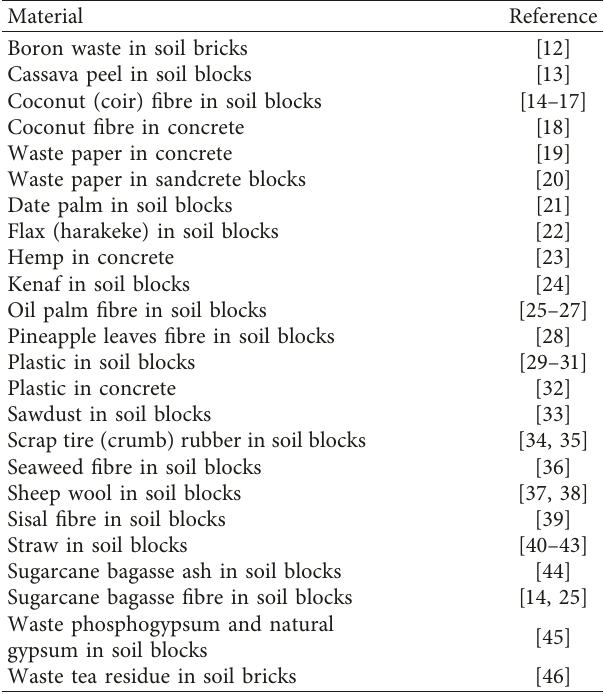
Table 1: Some studies on the properties of sustainable construction materials produced with